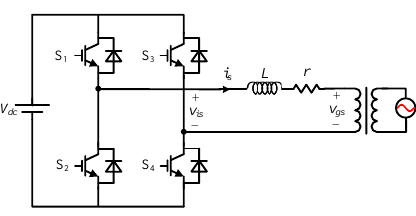
Figure 1. Single-phase grid-connected full bridge voltage source inverter.